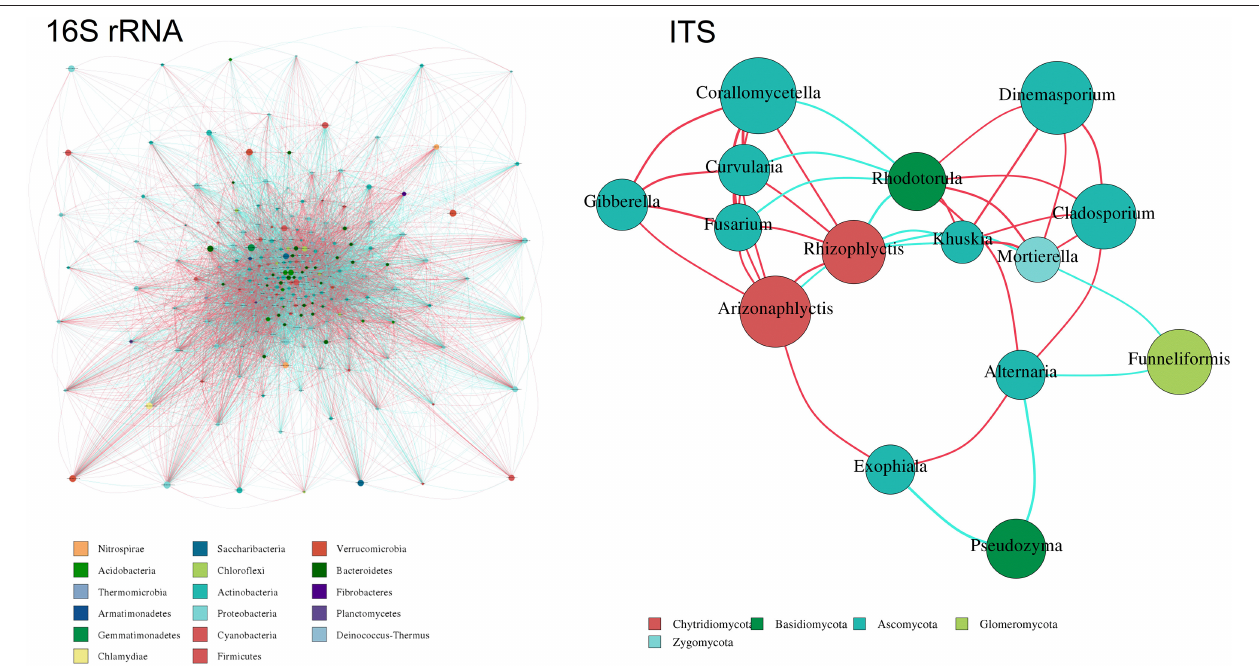
FIGURE 8 | Co-occurrence network analysis of 16S rRNA and ITS. Different nodes represent different genus, node size represents the average relative abundance of the genus, the same branch of the node color is the same (as shown in the example), and the thickness of the connection between the nodes and the species of the correlation coefficient absolute value is positively correlated.